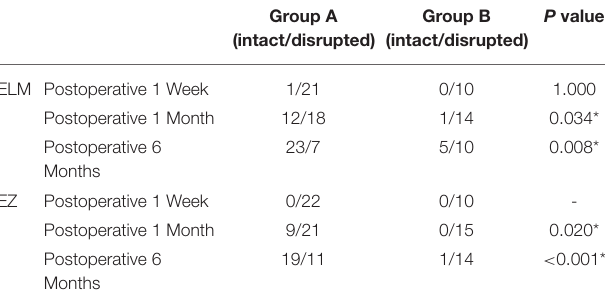
TABLE 3 | Cases of ELM/EZ restored in groups A and B over time.